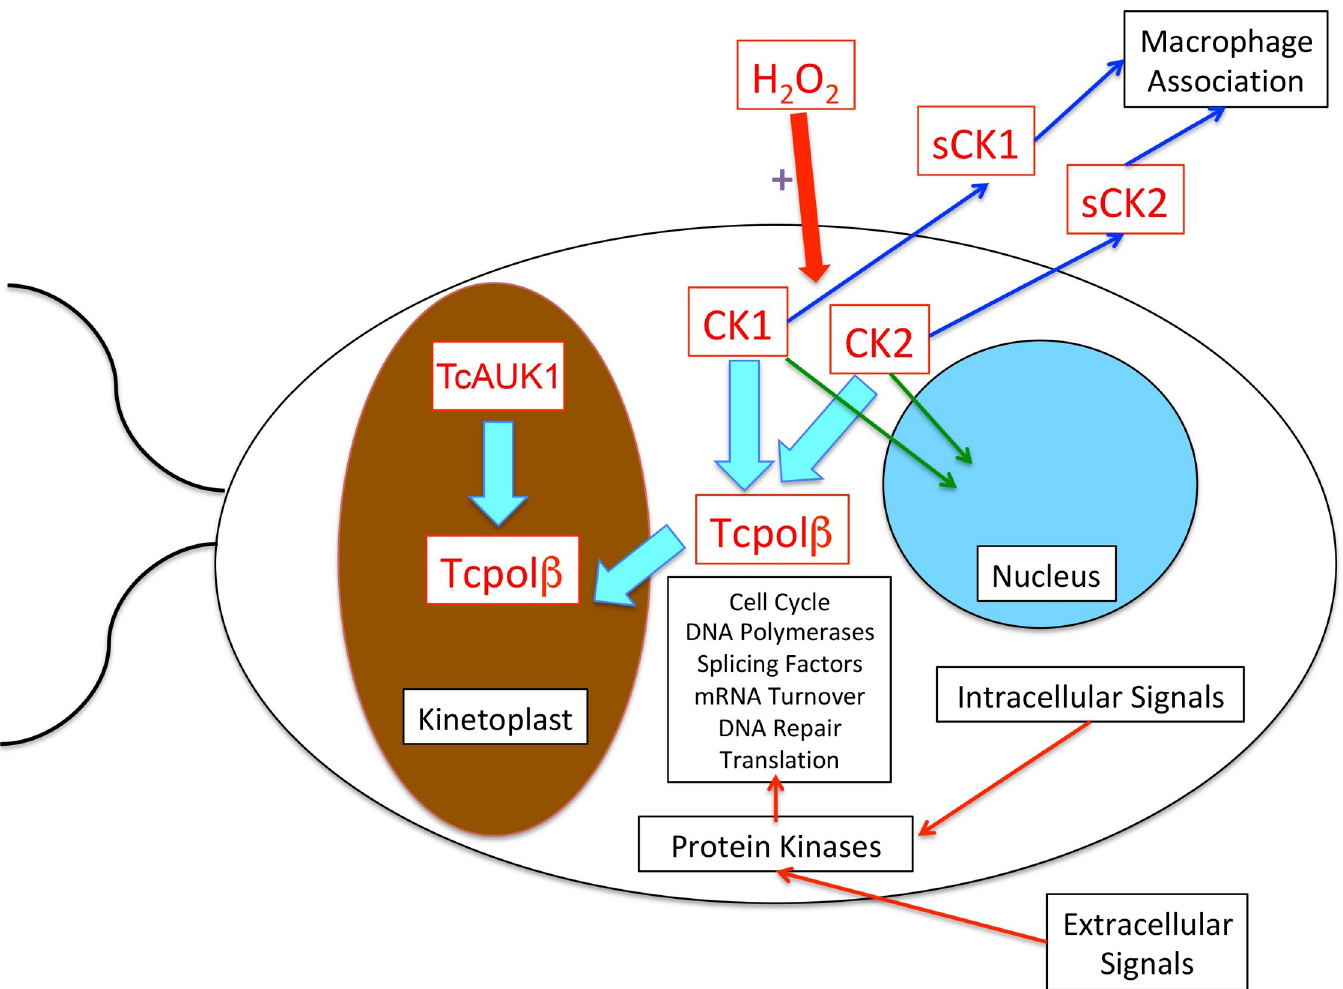
Fig 7. Hypothesis on signal transduction in trypanosomatids. Extracellular and/or intracellular signals can trigger protein kinase cascades, which can modify key downstream regulatory or effector molecules involved in DNA replication, mRNA splicing, mRNA turnover, mRNA translation, DNA repair, cell cycle and